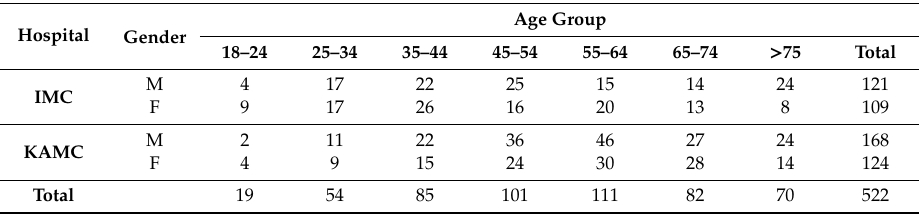
Table 3. Demographics of surveyed patients.